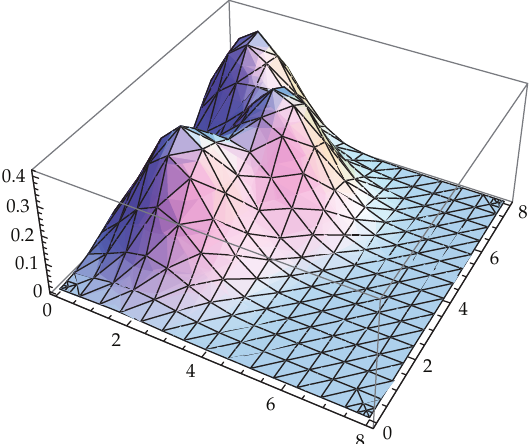
Figure 4: Overlapping appearance of di ff erent type kernel of EC, ρ (cid:2) P (cid:3) (cid:4) (cid:2) 2 π (cid:3) − (cid:2) 1 / 2 (cid:3) (cid:2) e − (cid:2) 1 / 2 (cid:3)(cid:2)(cid:2) x − 1 . 71 (cid:3) 2 (cid:9)(cid:2) y − 2 . 79 (cid:3) 2 (cid:3) (cid:9) e − (cid:2) 1 / 2 (cid:3)(cid:2)(cid:2) x − 3 . 05 (cid:3) 2 (cid:9)(cid:2) y − 5 . 25 (cid:3) 2 (cid:3) (cid:9) e − (cid:2) 1 / 2 (cid:3)(cid:2)(cid:2) x − 1 . 05 (cid:3) 2 (cid:9)(cid:2) y − 7 . 25 (cid:3) 2 (cid:3) (cid:3)